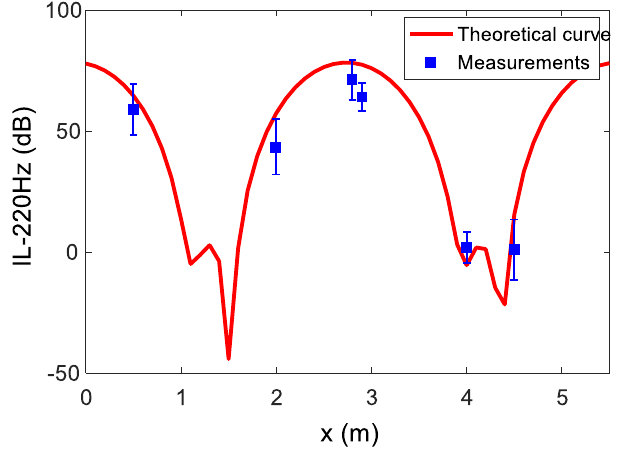
Figure 15. Optimization of installation position of RSHPA (220 Hz).